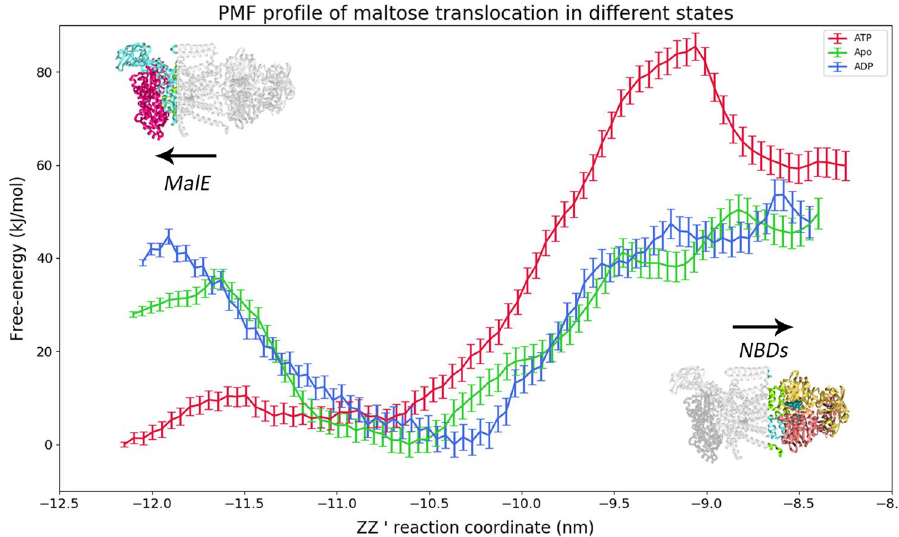
Figure 7. Potential of mean force (PMF) profiles for the ATP, ADP and Apo states. The ATP profile is represented in red, the ADP profile in dark blue and the Apo profile in green. The error bars correspond to a 95% confidence interval at each point, assuming that the energy values in each bin follow a normal